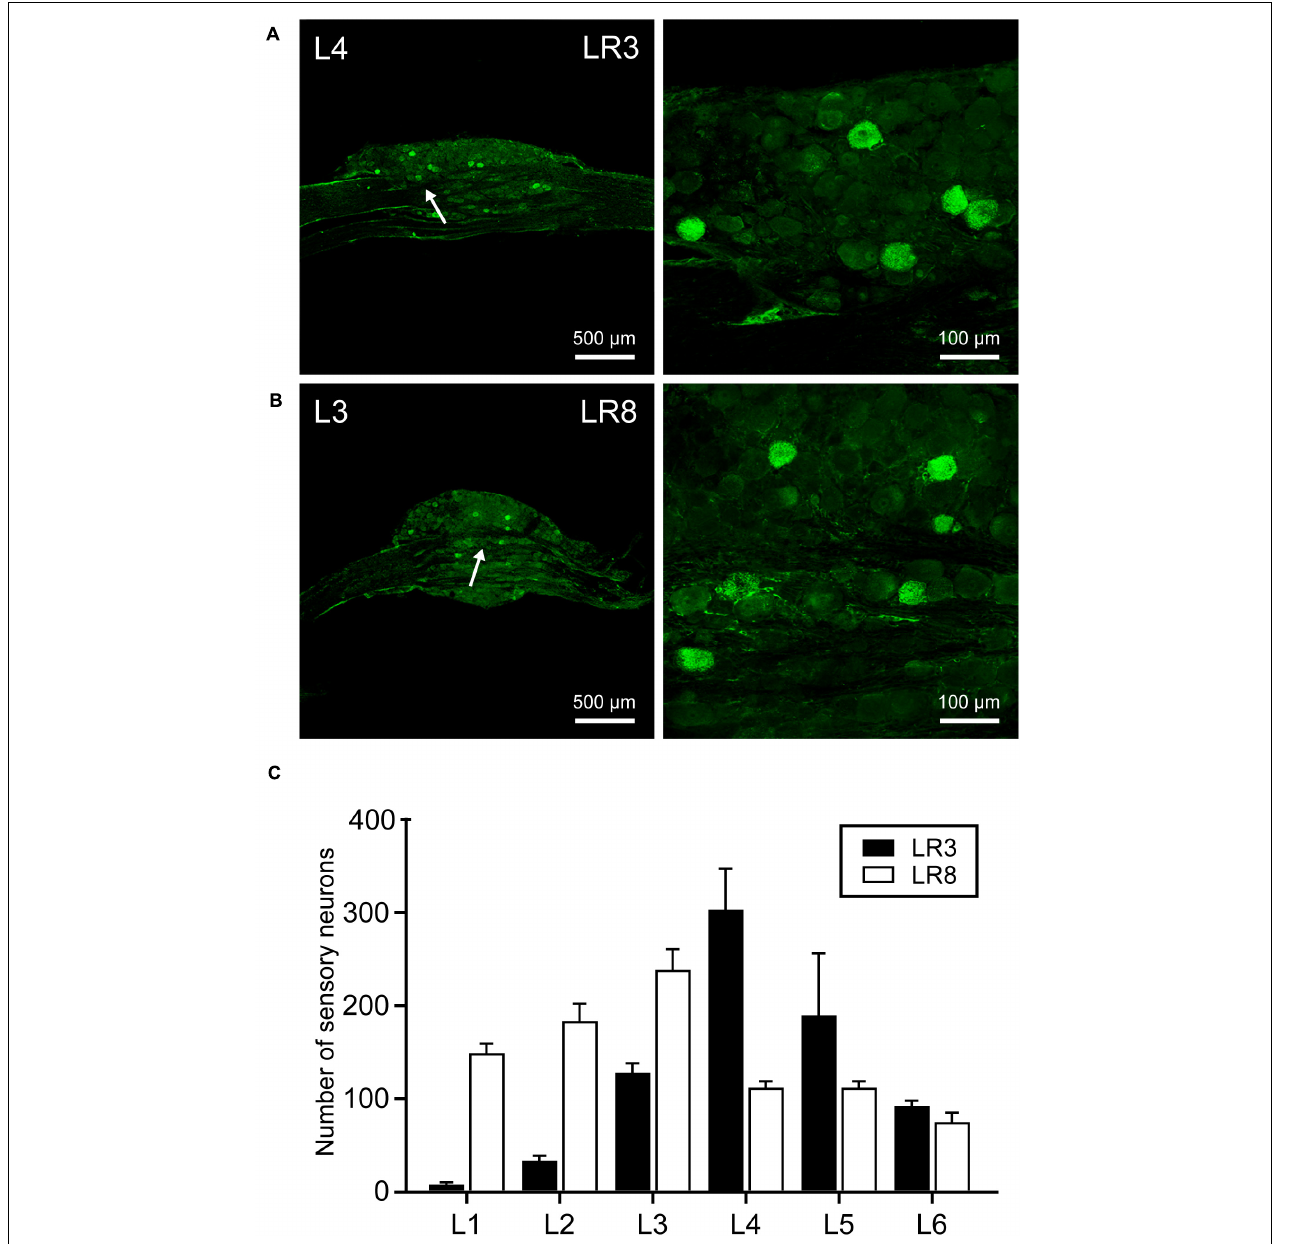
FIGURE 2 | Distribution of the labeled sensory neurons with cholera toxin subunit B (CTB). (A,B) Representative photos from lumbar (L) 3 and L4 dorsal root ganglia (DRG) showing the CTB labeled sensory neurons associated with “Taichong” (LR3, A ) and “Ququan” (LR8, B ). And their magnified photos (arrowheads) showing the labeling in detail. (C) The distribution of CTB labeled sensory neurons for LR3 and LR8 from L1 DRG to L6 DRG in average number ( n =